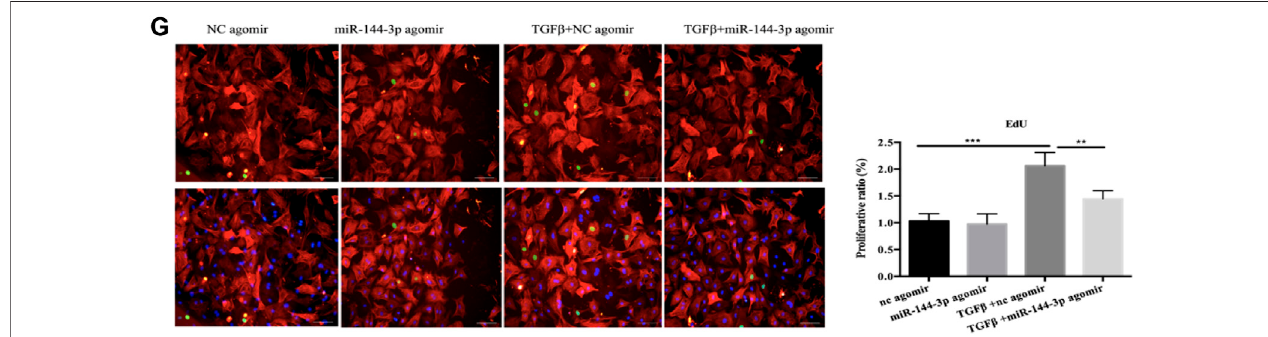
FIGURE6| FunctionalstudyofmiR-144-3p invitro . (A) .qRT-PCRanalysisofmiRNAbetweencardiomyocytes and fi broblasts(n=6). (B,C) .qRT-PCRanalysisof the transfection ef fi cacy of miR-144-3p with agomir/antagomir compared to controls (n = 6). (C – E) . Overexpression or downregulation of miR-144-3p did not perform effectsoncardiomyocytecellsizeandpathologicalhypertrophic markers(ANPandBNP),asevidenceby α -actin/DAPIstaining(n=4)andqRT-PCRanalysis(n=6). (F) . Decreased expression of miR-144-3p in cardiac fi brosis model induced by TGF β (n = 6). (G,H) . Forced expression of miR-144-3p attenuated TGF β -induced cardiac fi broblast proliferation and trans-differentiation, as evidenced by EdU/ α -SMA staining (n = 4) and qRT-PCR analysis of α -SMA, Col1a1 and Col3a1 (n = 6) (I,J) . inhibitionofmiR-144-3pdeterioratedTGFb-induced cardiac fi broblastsproliferationandtrans-differentiationasevidencedbyEdU/ α -SMAstaining(n=4)andqRT-PCR analysis (n = 6). Scale bar: 50um. *, p < 0.05; **, p < 0.01; ***, p <